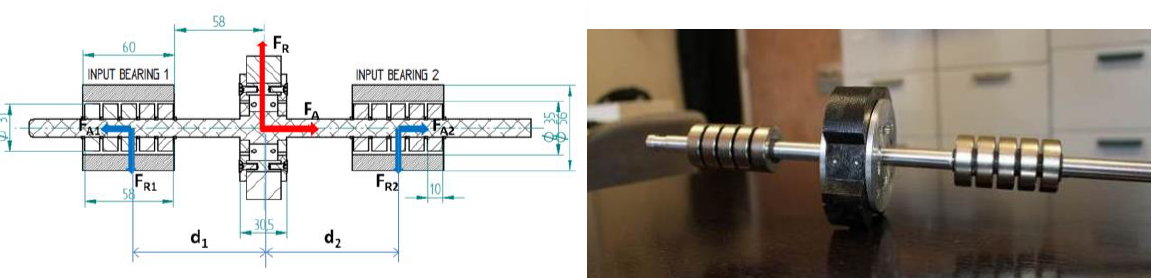
Figure 6. Mechanical drawing plan and prototype and of an axle supported by Superconducting Magnetic Bearings (SMBs).